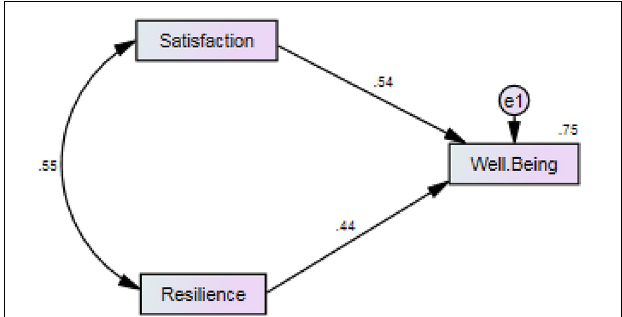
FIGURE 2 | The final measurement